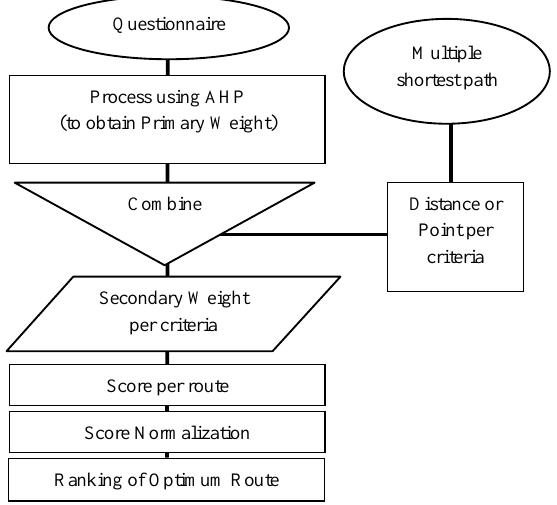
Figure 6. Flow of